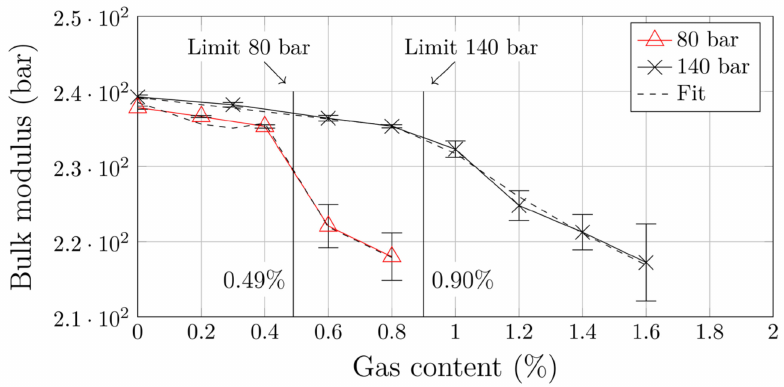
Figure 3. Reference dynamic solubility limits obtained for PGC 1.